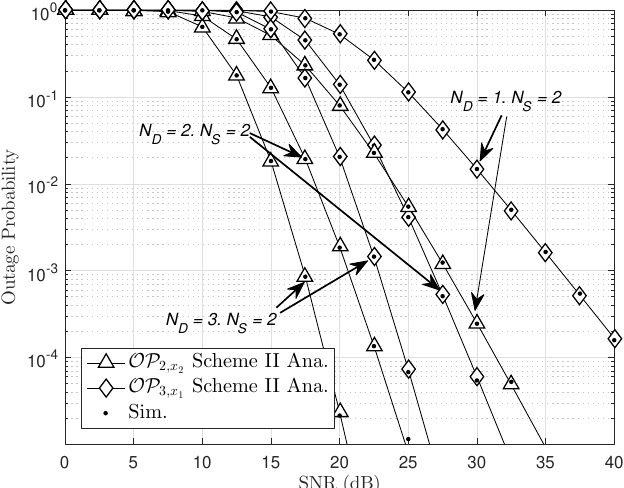
Figure 5. Outage probability of Scheme II with different N D , N S = 2, d 1 = 2 m, d 2 = 3 m, a 1 = 0.2 and a 2 =